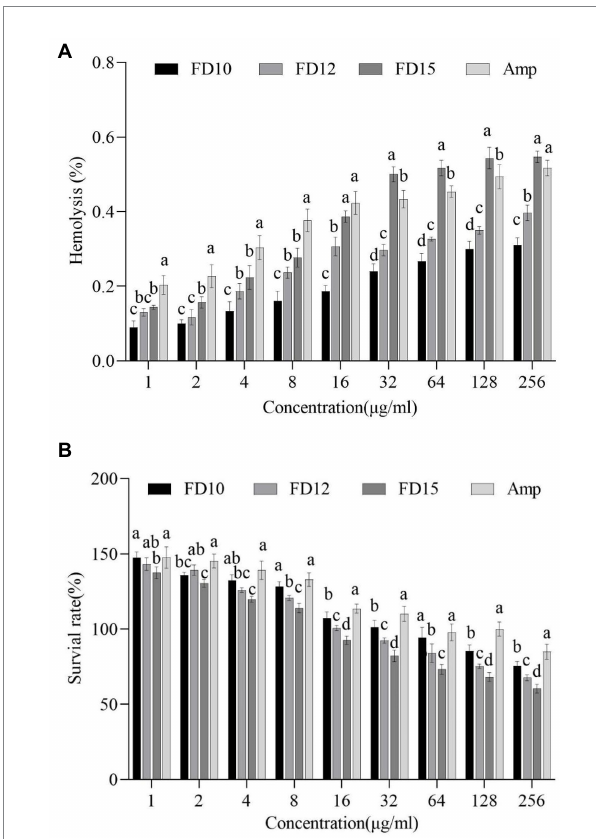
FIGURE 5 (A) Hemolytic activity against mouse erythrocytes ( n = 3) and (B) cytotoxicity against mouse RAW 264.7 macrophages ( n = 3) of FD10, FD12, FD15, and ampicillin (Amp). Different lowercase letters (a, b, c, d) indicate a significant difference ( p < 0.05) within each identical-concentration experiment, based on one-way ANOVA. ‘a’ indicates the largest mean in the group; ‘b’, ‘c’, and ‘d’ indicate the largest, second largest, and third largest mean, respectively, that is significantly different from